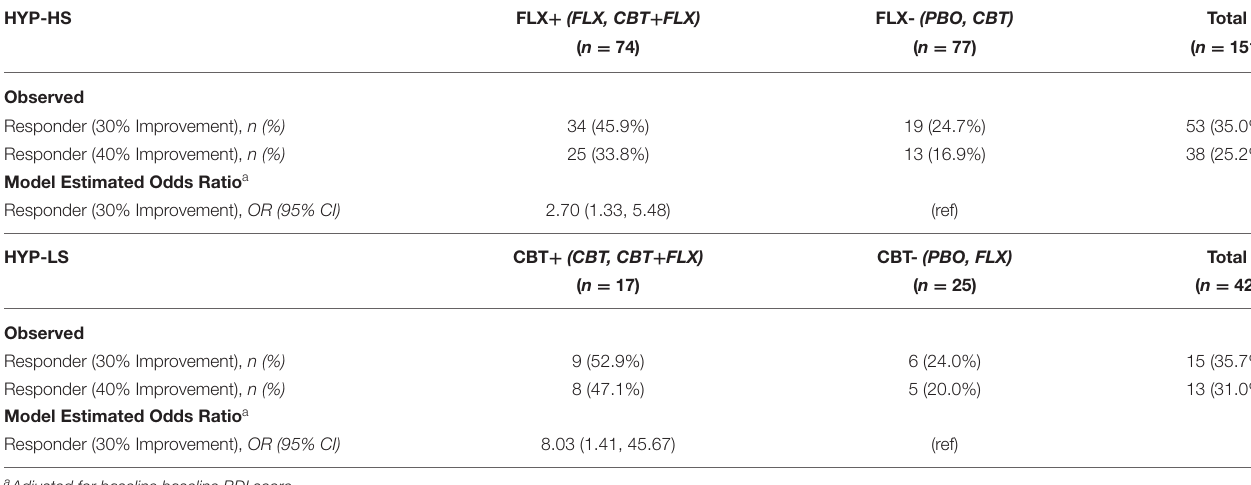
TABLE 3 | Observed Responder Status and Model Estimates by combined FLX + and combined FLX- groups in HYP-HS participants and by combined CBT + and combined CBT- groups in HYP-LS participants. HYP-HS